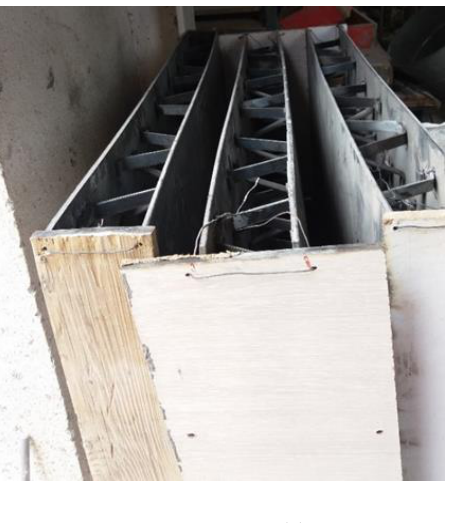
Figure 9. Prepared SCS slabs. Table 7. The arrangement of holes and connectors.